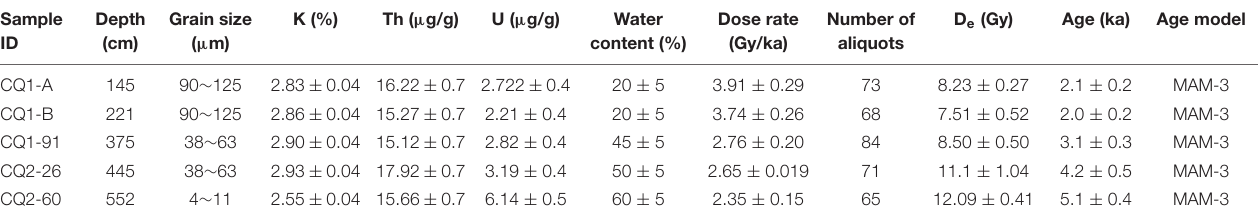
TABLE 1 | Luminescence dating